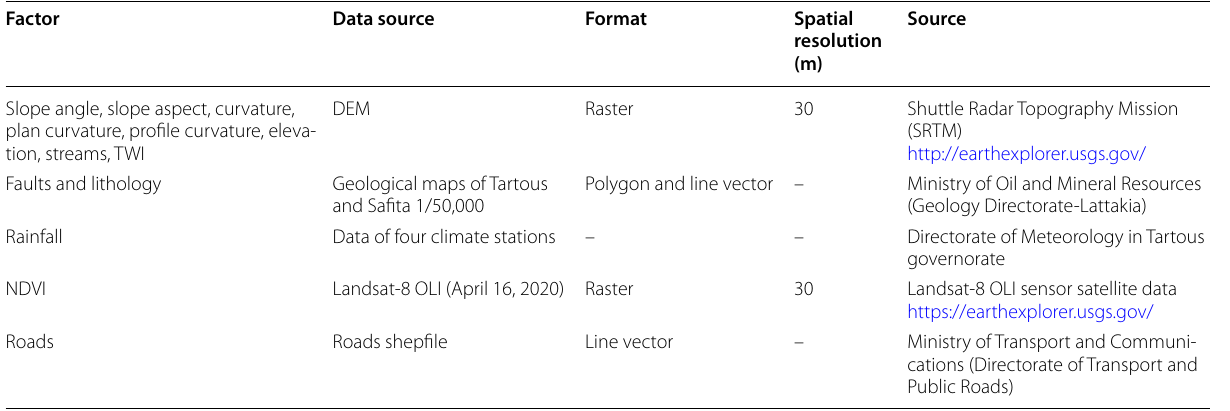
Table 1 Description and source of data used